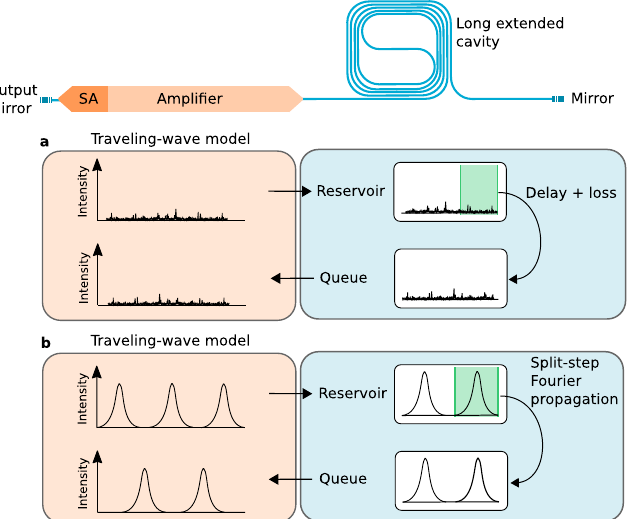
Figure 2. Mode-locked laser simulation flow, consisting of a traveling-wave model for the active region and a split-step Fourier propagation algorithm for the extended passive waveguide cavity. ( a ) In case no pulses are observed, e.g. at laser start-up, the split-step Fourier algorithm is not employed and the extended cavity is simply represented by a delay with some loss. ( b ) When pulses are observed, the split-step Fourier method is used and dispersive and nonlinear effects are accounted